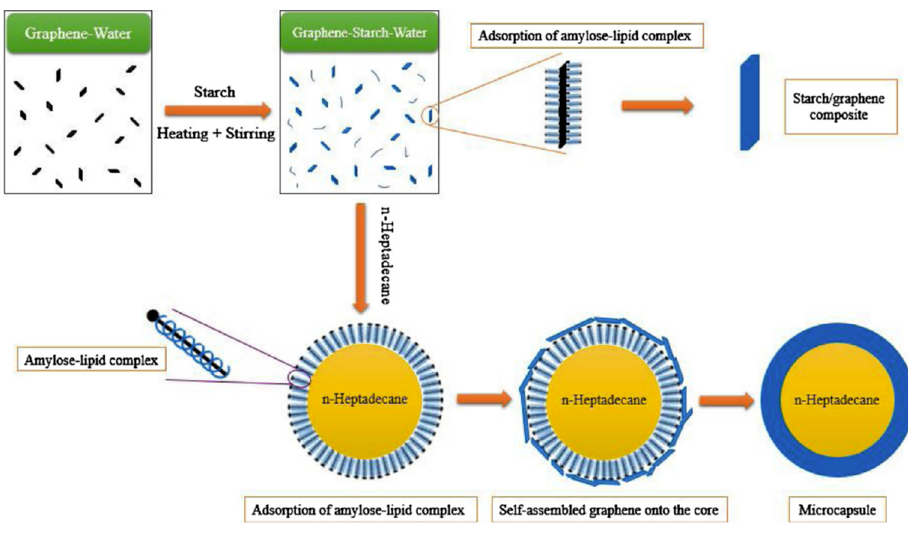
Figure 9. Preparation mechanism of starch/graphene shell microcapsules [77].